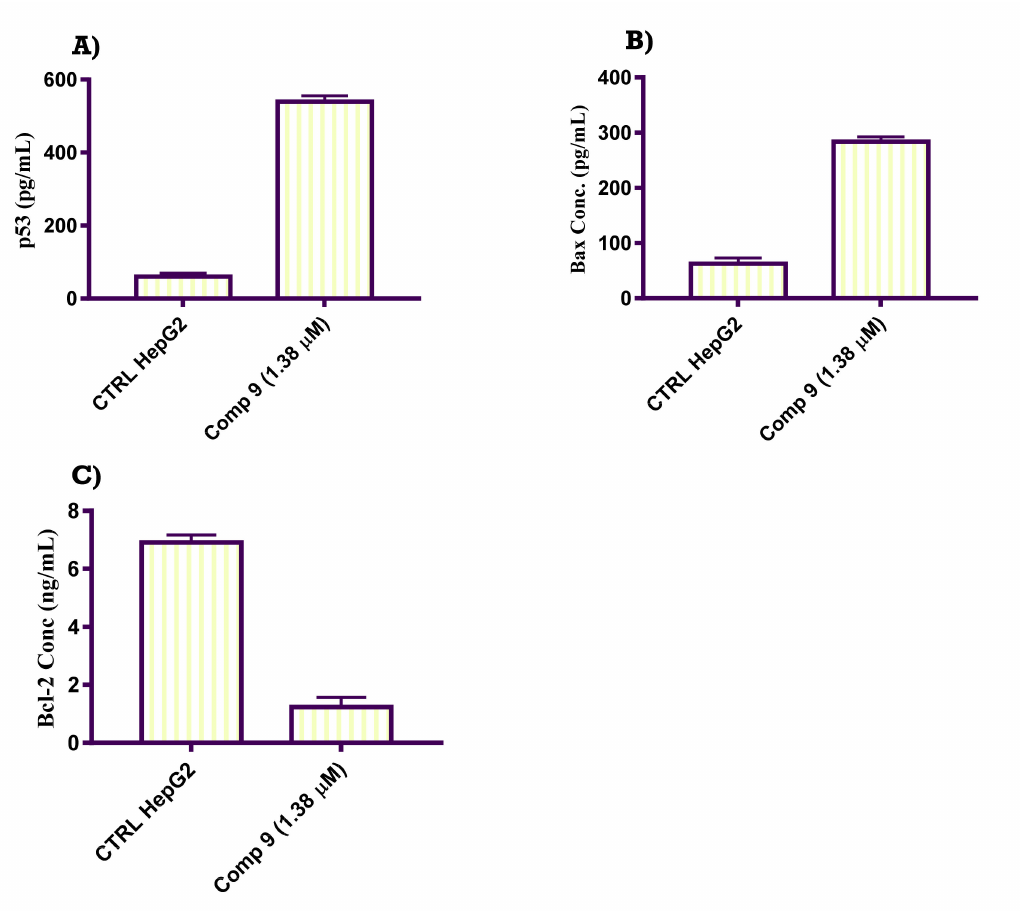
Figure 6. ( A ) The quantification of p53. ( B ) The quantification of Bax. ( C ) The quantification of Bcl-2. HepG2 cells were treated with 1.38 µ M of compound 9 for 48 h and apoptotic markers were determined by ELISA assay.